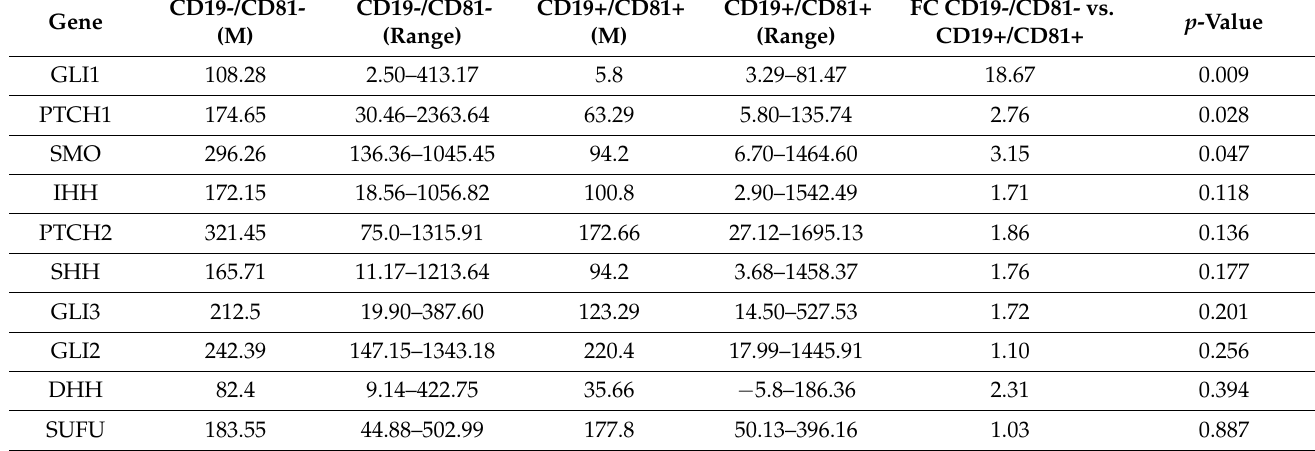
Table 4. Digital PCR validation of the 10 HH genes signature across the prospective NDMM patients’ cohort. A prospective cohort of 22 patients was employed to validate the ddPCR assay on CD138+ plasma cells. An immunophenotypic characterization of the neoplastic clone permit the stratification according to their differentiation status. In particular, 10 out of 22 were CD19+/CD81+ (CLU1— immature/less differentiated phenotype) and 12 out of 22 were CD19-/CD81- (CLU2—mature/more differentiated phenotype). Screening of these patients with the 10 HH-genes signature confirms their differentiation status. Indeed, the comparison of the absolute quantification values between the two groups highlights the overexpression of 10 HH genes signature in CD19-/CD81- patients, the most differentiated